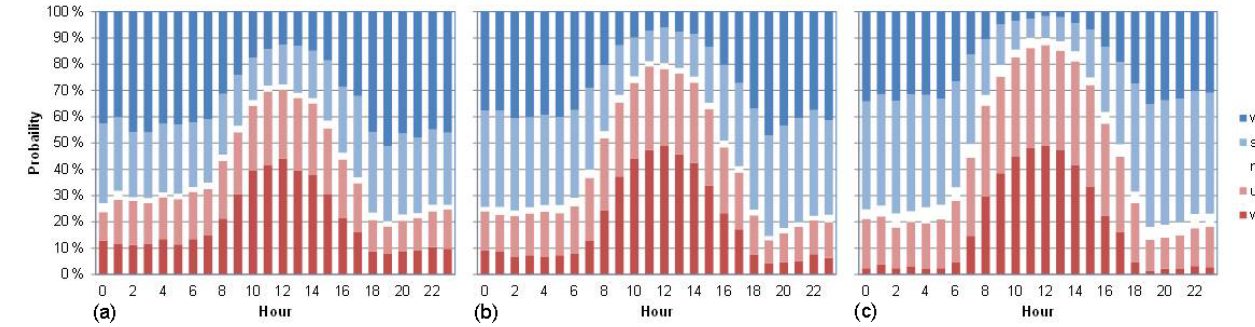
Figure 6. Distribution of atmospheric stability with hour based on z/L obtained with the sonic anemometer at different heights: (a) 115.5m, (b) 75.5m and (c) 39.5m. vs, very stable; s, stable; n, neutral; u, unstable; vu, very